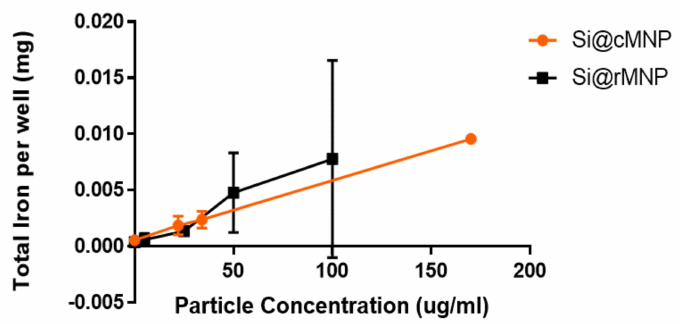
Figure 4. Iron uptake into cells of Si@cMNP (orange) and Si@rMNP (black). ICP OES showing the amount of iron present within 50,000 MDA-MB-231 cells after 24 h incubation with 0, 0.022, 0.034, and 0.17 mg/mL of Si@cMNP, and 0, 0.005, 0.025, 0.050, 0.100 mg/mL of